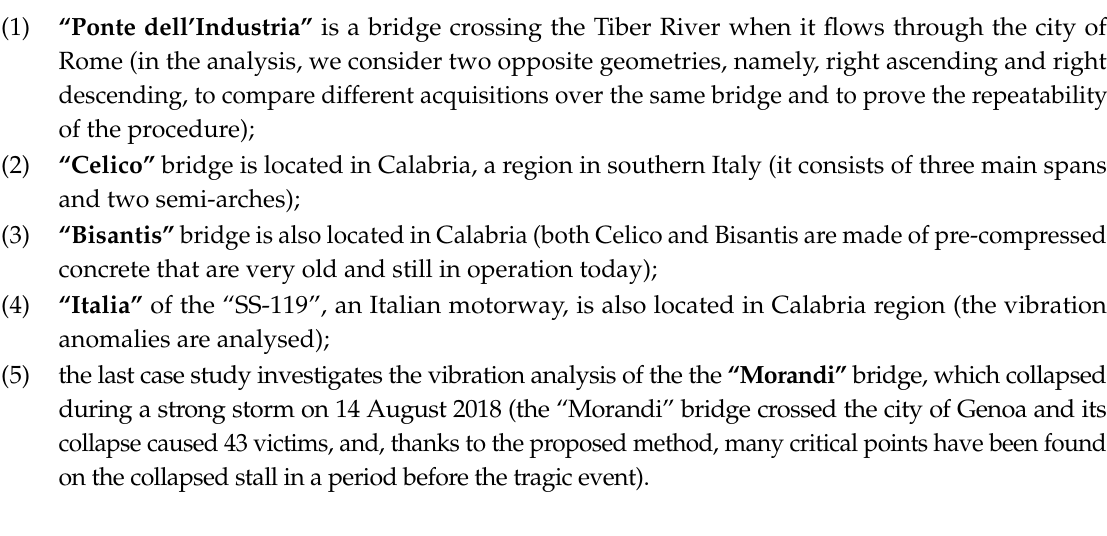
Table 1. Characteristics of the SAR acquisitions.